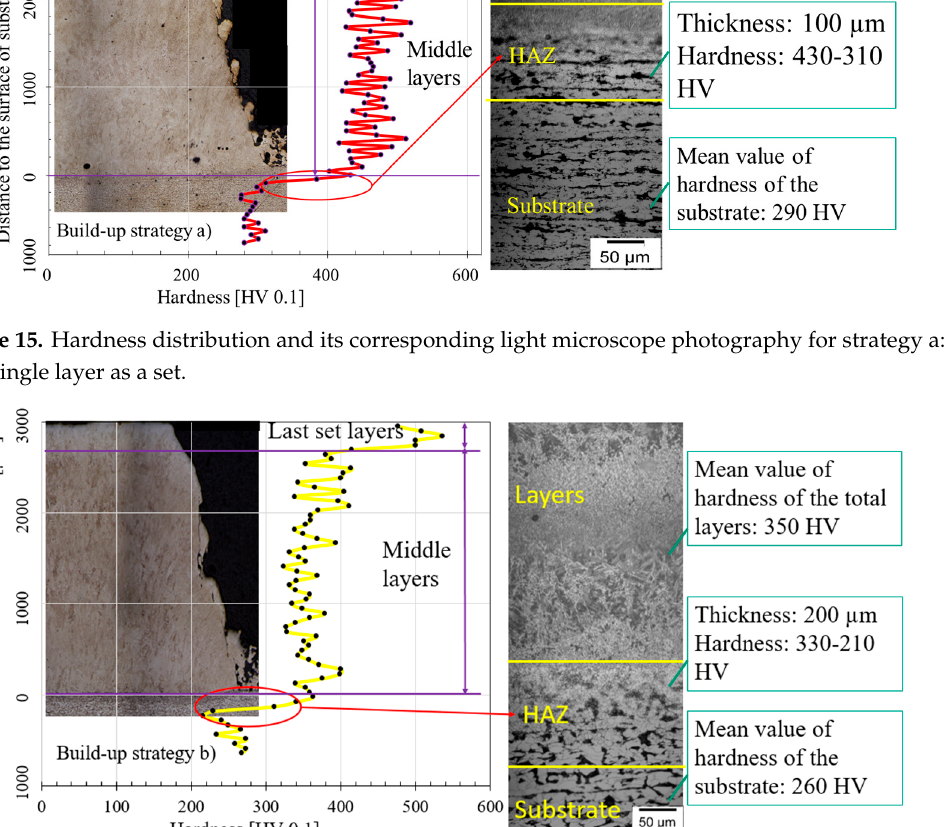
Figure 16. Hardness distribution and its corresponding light microscope photography for strategy b: Three layers as a set.